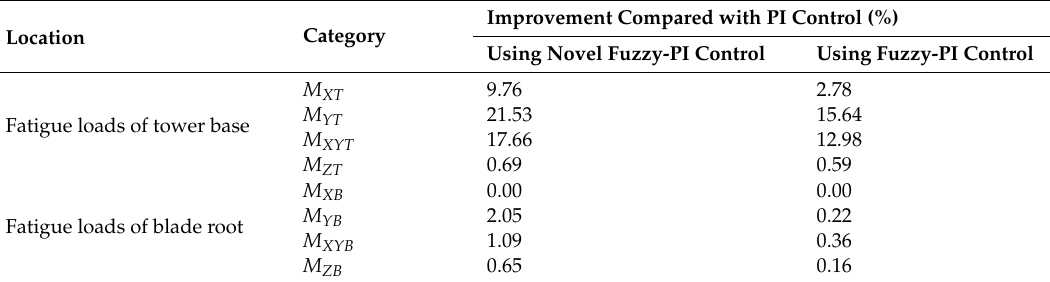
Figure 9. Moments under normal turbulent wind conditions. Table 5. Analysis of fatigue loads under normal turbulent wind conditions.